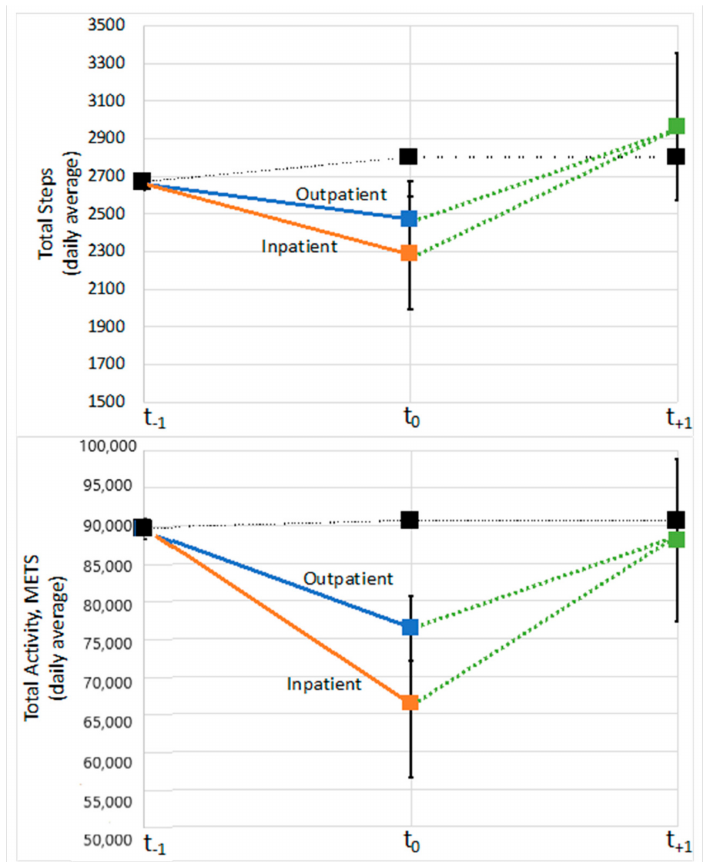
Figure 3. Change in total steps and total metabolic cost (METs) from the period prior, during, and immediately after a pneumonia episode. Group means were similar at baseline and those with outpatient (blue) and inpatient (orange) pneumonia events decreased then returned to baseline in the subsequent period (green). Those without any pneumonia events are shown in black. Due to sample sizes, inpatient and outpatient pneumonia groups were grouped together in the